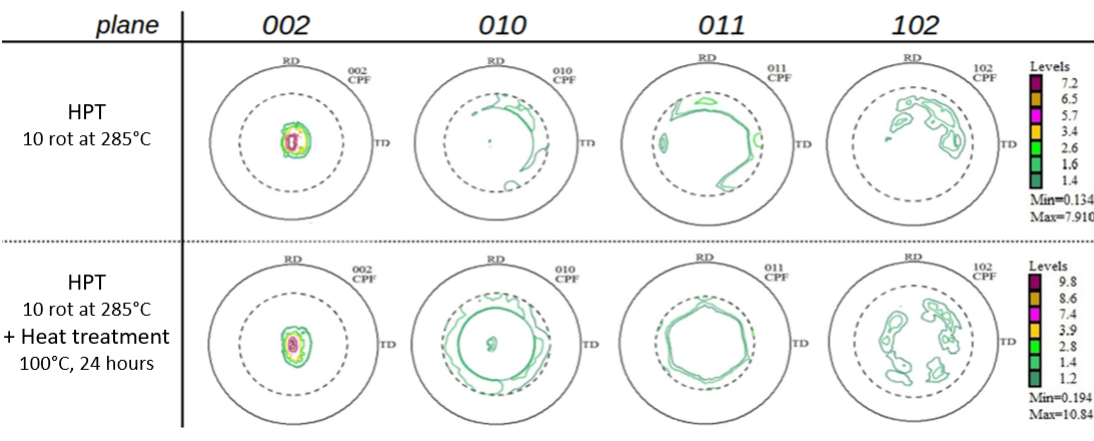
Figure 7. Pole figures displaying crystallographic textures of Mg5Zn0.15Ca after various treatments. Values of Young’s modulus E of all materials and treatments were evaluated